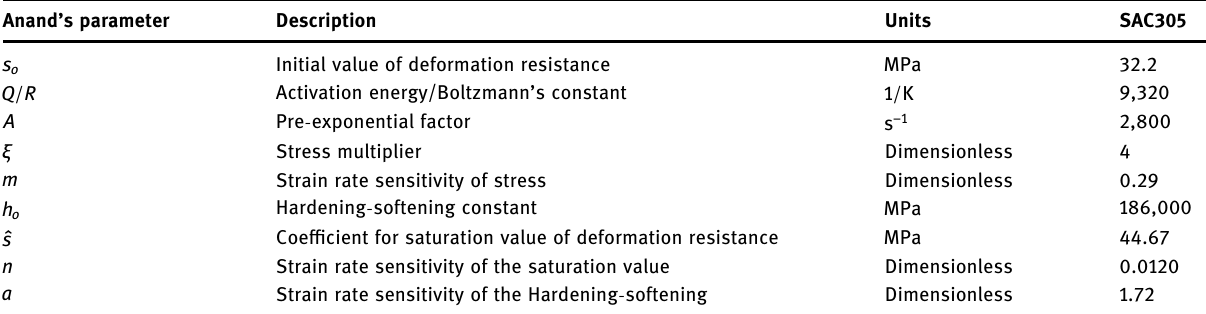
Table 3: Anand model parameters used in the FE model for the SAC305 solder alloy [ 23 ] Anand ’ s parameter